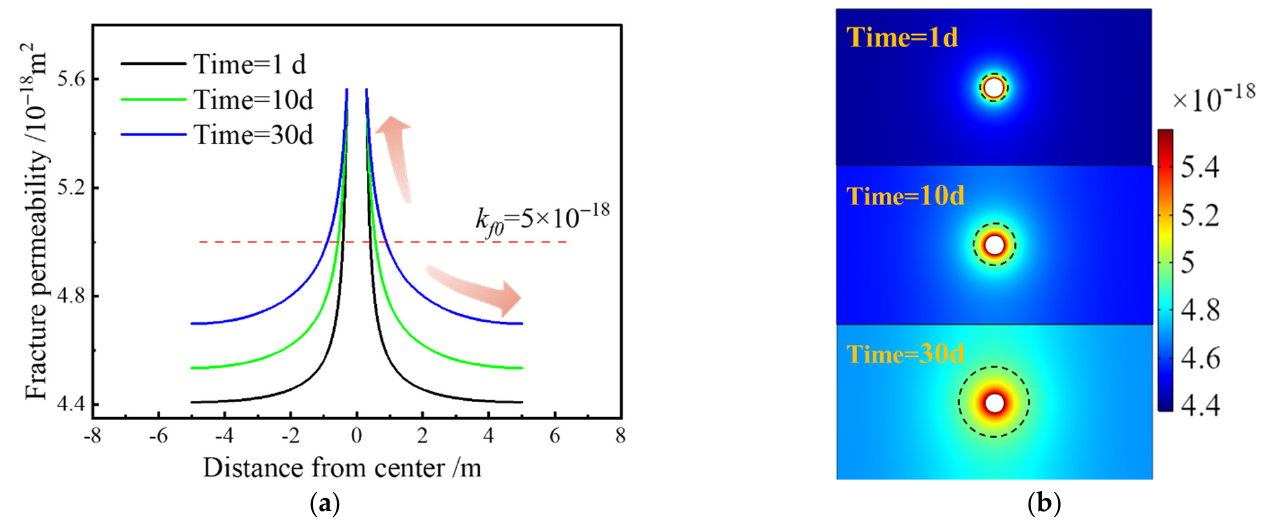
Figure 5. Fracture permeability evolution (( a ) the permeability curves with distance and ( b ) the permeability nephograms at different times).